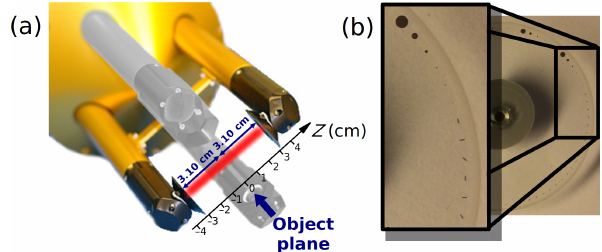
Figure 3. (a) 2D-S probe with a schematic of the laser beam. The probe consists of two pairs of arms allowing measurements in two orthogonal directions. We only consider one couple of arms here. The object plane is located in the middle of the laser beam be- tween the two arms. (b) Spinning disc with imprinted opaque parti- cle shapes.